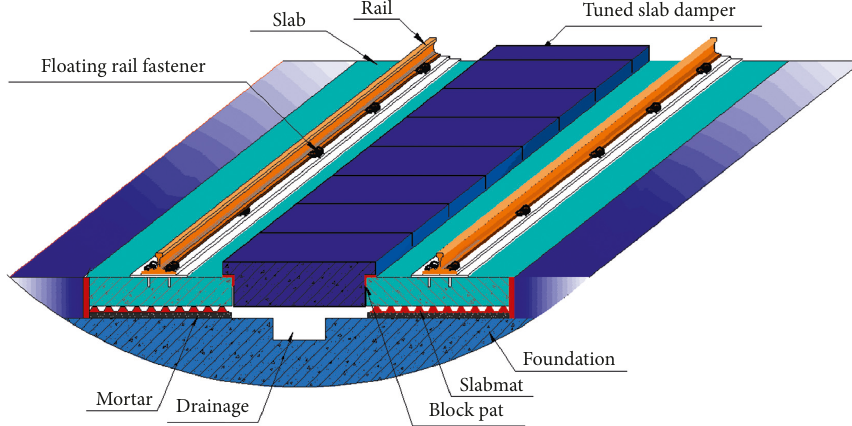
Figure 5: Track schematic diagram of the fastener/tuned slab damper/floating